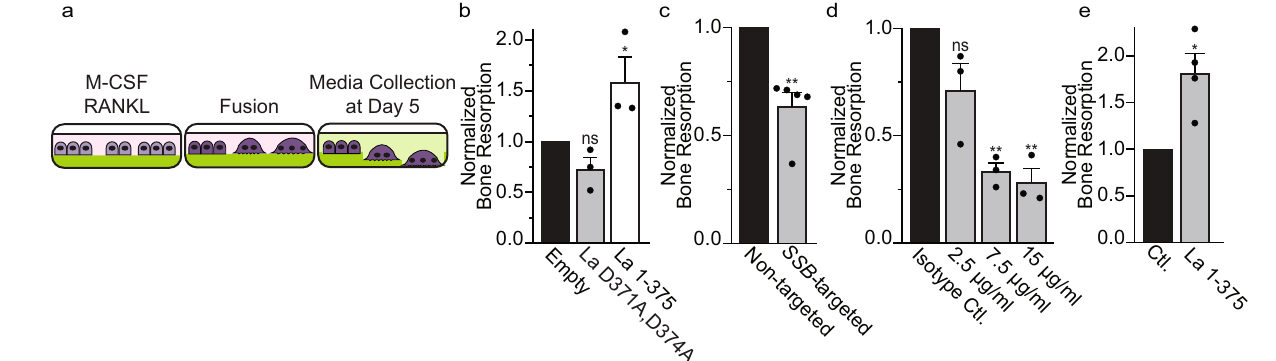
Fig. 6 | Interfering with La in fl uences bone resorption by human osteoclasts. a Illustration depicting the use of fl uoresceinamine-labeled chondroitin sulfate trapped in calcium phosphate coated plates to assay bone resorption. b Bone resorption in osteoclasts overexpressing uncleavable La (D371A, D374A) or trun- cated La (1-375) normalized to that for the osteoclasts transfected with empty plasmid. ( n =3) ( P =0.06 and 0.05). c Bone resorption in osteoclasts transfected with siRNA targeting La transcript normalized to that for non-targeted siRNA.